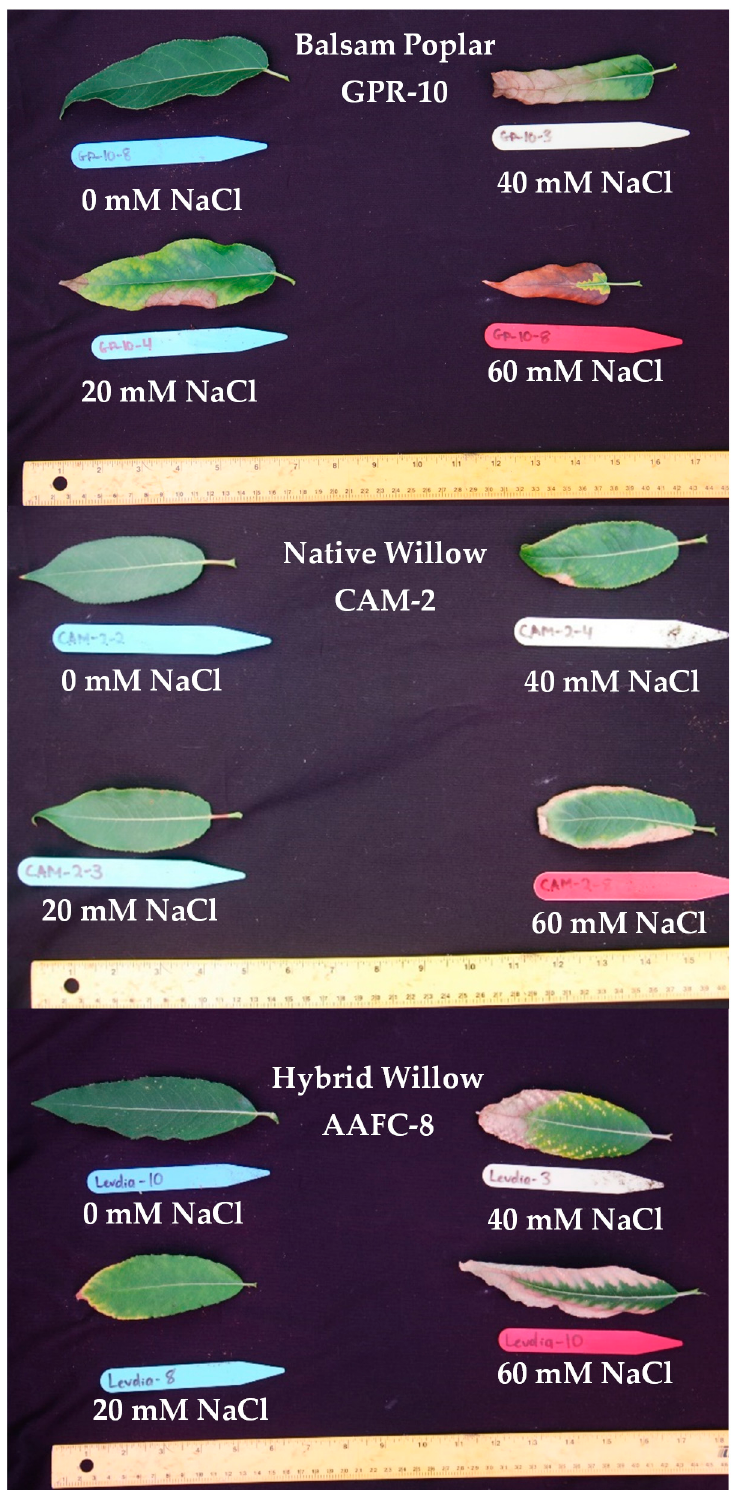
Figure 2. Balsam poplar, native willow, and hybrid willow leaves after 12 weeks of growth with salinity